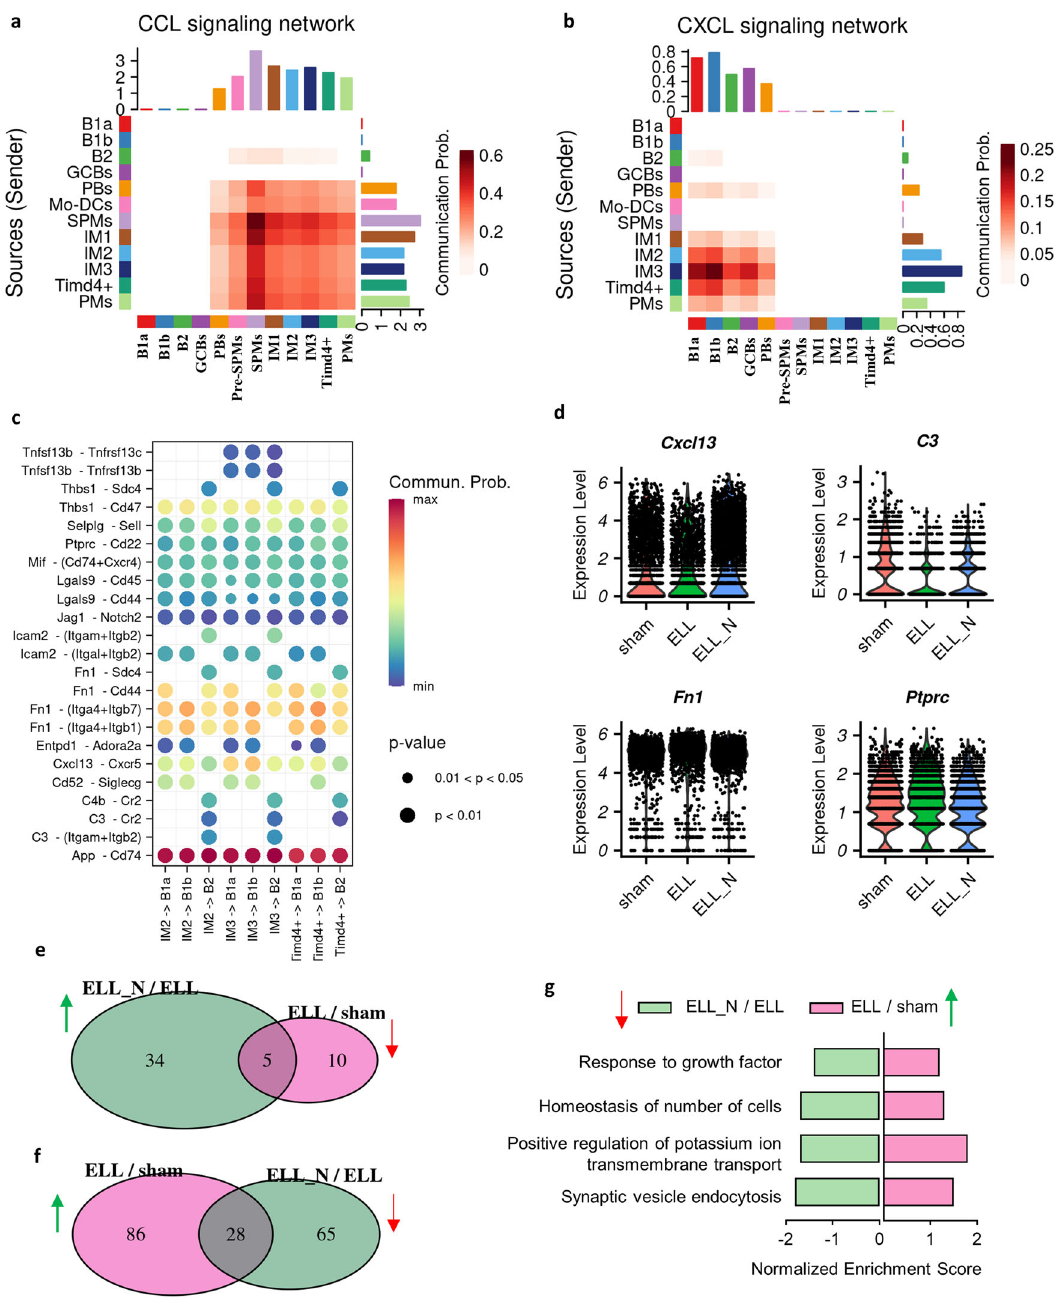
Fig. 8 Niclosamide rescued the disrupted intercellular communications from macrophages to B cells. a Heatmap showing the interactions between macrophages and B cells in terms of CCL signalling networks. b Heatmap showing the interactions between macrophages and B cells in terms of CXCL signalling networks. c Bubble plot showing all signi fi cant expressed ligand-receptor pairs identi fi ed between three subtypes of “ large ” macrophages (IM2, IM3, Timd4 + LPMs) and three subtypes of B cells (B1a, B1b, B2). d Vlnplot showing the differential expressed genes in macrophages. All genes shown here were signi fi cantly ( p < 0.05) differentially expressed as determined by the “ wilcox ” test within the Seurat package. e Overlaps of GO biological processes in B cells that were suppressed by ELL (ELL/sham) but enhanced by niclosamide (ELL_N/ELL). f Overlaps of GO biological processes in B cells that were promoted by ELL (ELL/sham) but suppressed by niclosamide (ELL_N/ELL). g Overlaps of GO biological processes that were promoted by ELL by suppressed by